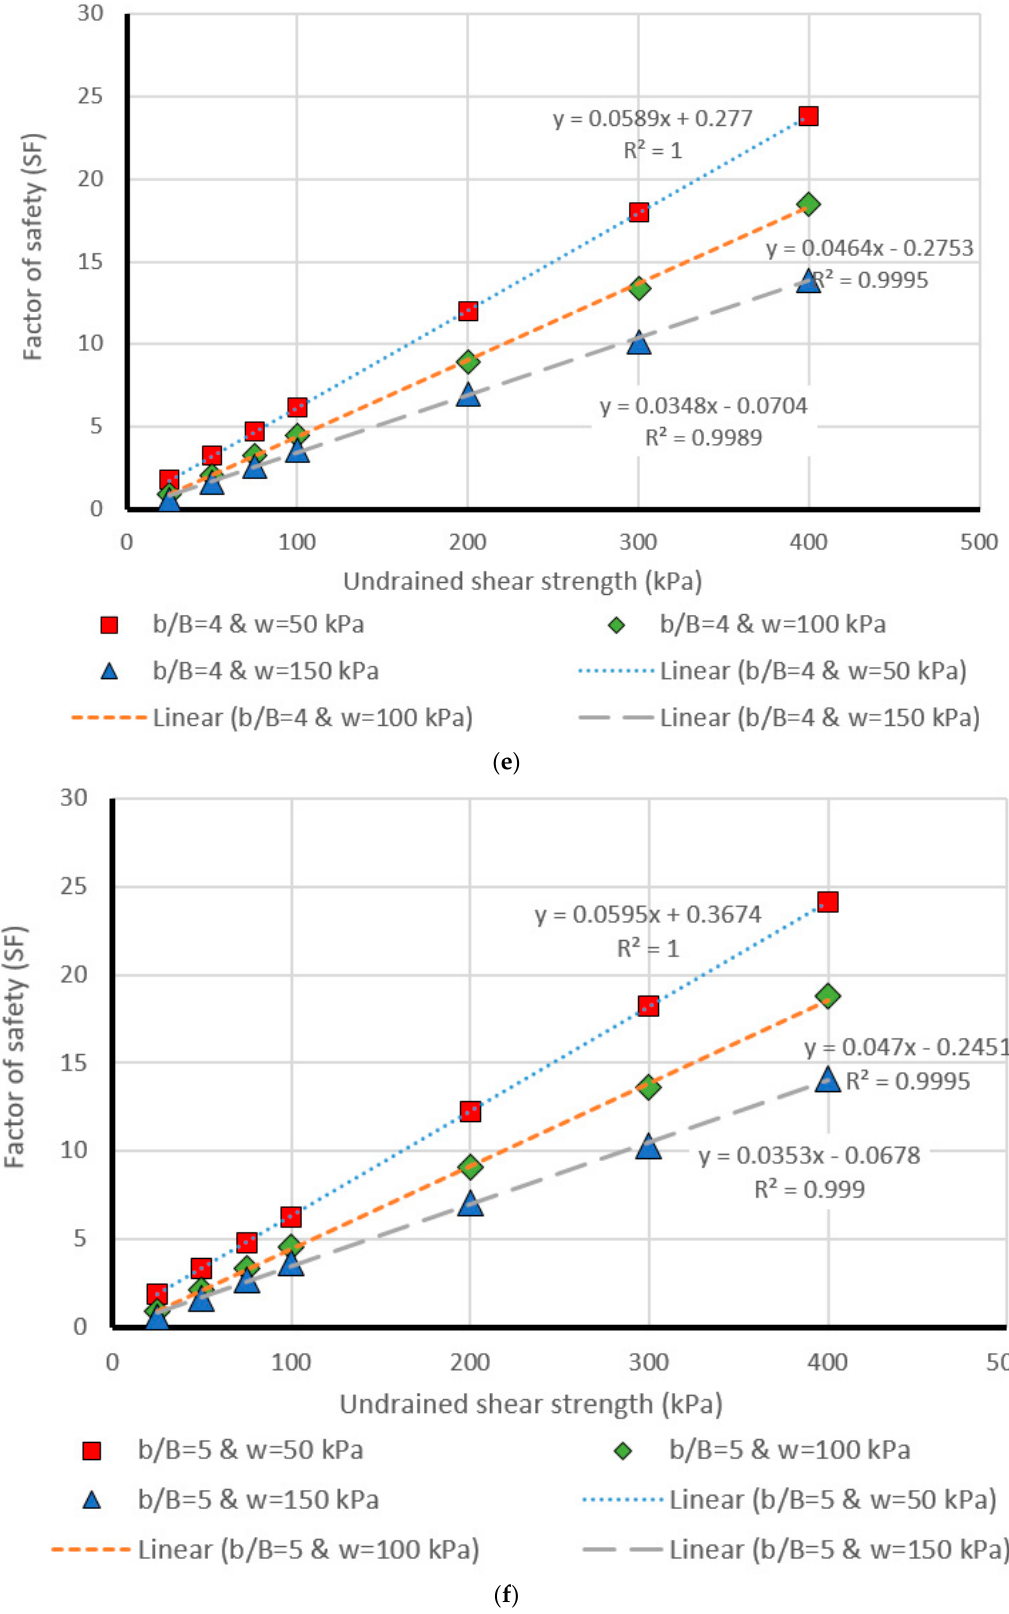
Figure 9. Comparison of the MLP estimation and real values of FS for the β = 30°, ( a ) b/B = 0, ( b ) b/B = 1, ( c ) b/B = 2, ( d ) b/B = 3, ( e ) b/B = 4, ( f ) b/B = 5.